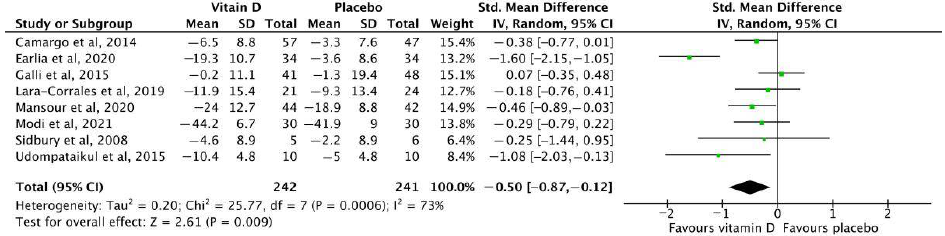
Figure 4. Meta-analysis of the change in EASI or SCORAD before and after intervention among children with atopic dermatitis [48–55]. EASI: Eczema Area and Severity Index; SCORAD: Scoring Atopic